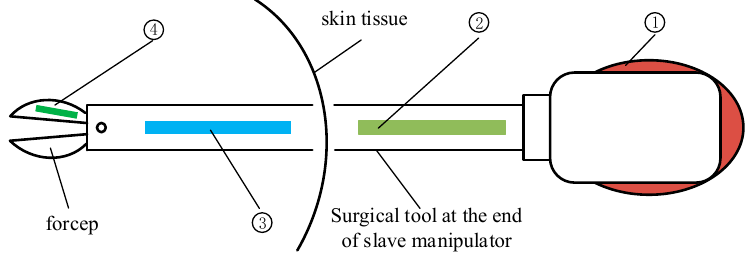
Figure 1. Layout scheme of force-sensing elements.